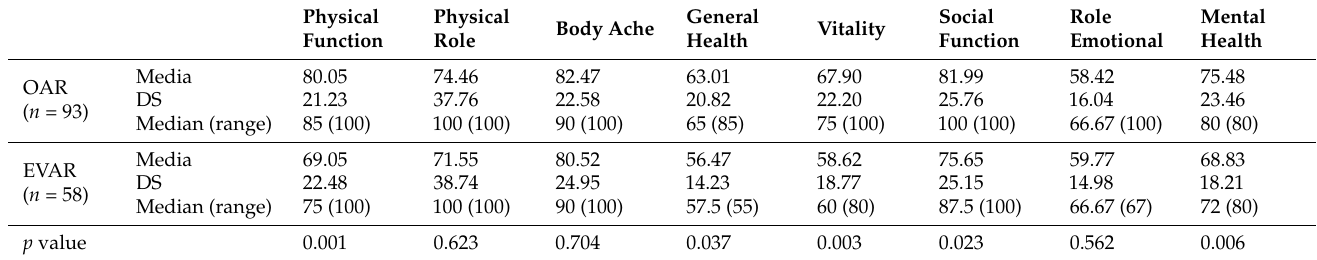
Table 2. Global scores obtained on the health scales of the SF-36 Questionnaire according to the type of surgical intervention performed. Open abdominal repair (OAR), endoprosthesis abdominal repair